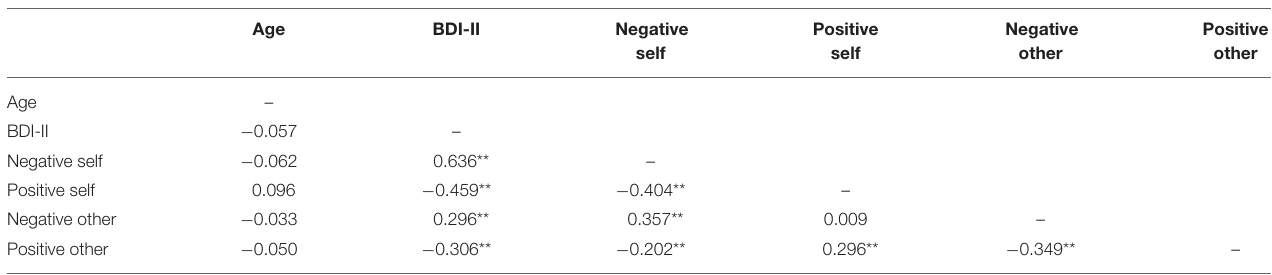
TABLE 3 | Spearman’s bivariate correlation analysis of age, BDI-II score, and BCSS scores.